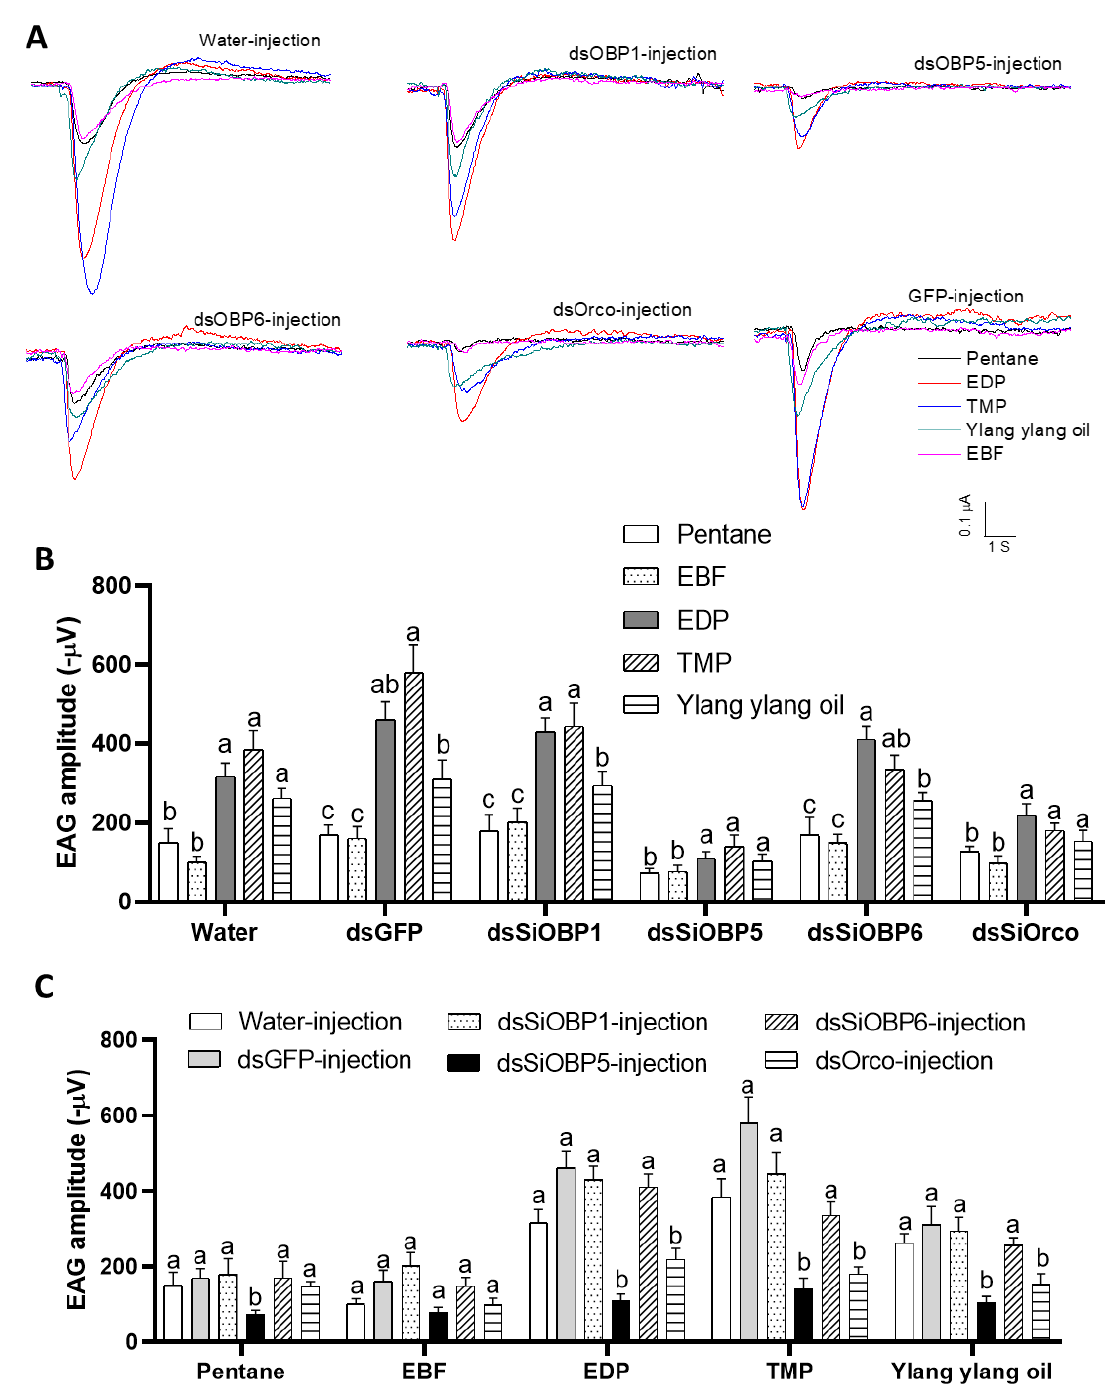
Figure 2. The EAG responses of dsSiOBP1-, dsSiOBP5-, and dsSiOBP6- and dsSiOrco-injected fire ant workers. ( A ) The representative EAG traces elicited by EDP, EBF, TMP, and ylang ylang oil 72 h post injection with water, dsGFP, dsSiOBP1, dsSiOBP5, dsSiOBP6, and dsSiOrco. ( B ) The EAG responses to water, dsGFP, dsSiOBP1, dsSiOBP5, dsSiOBP6, and dsSiOrco 72 h post injection. ( C ) The EAG responses to pentane, EBF, EDP, TMP, and ylang ylang oil 72 h post injection with the dsRNAs. The different letters on the top of the bars indicate statistically significant differences, as determined by one-way analysis of variance with Tukey’s HSD test, and significance was set at p < 0.05. ( B ) and ( C ) reflect the same data.